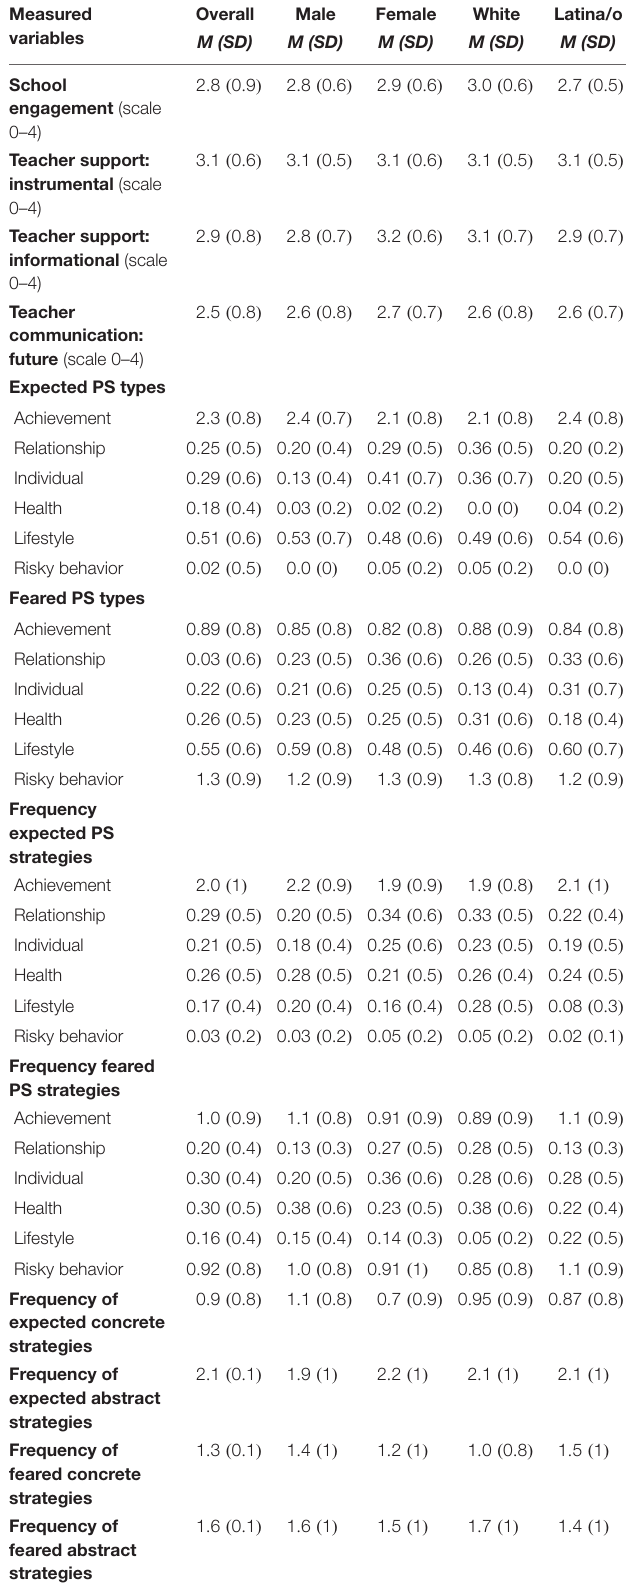
TABLE 1 | Means (SD) associated with measured